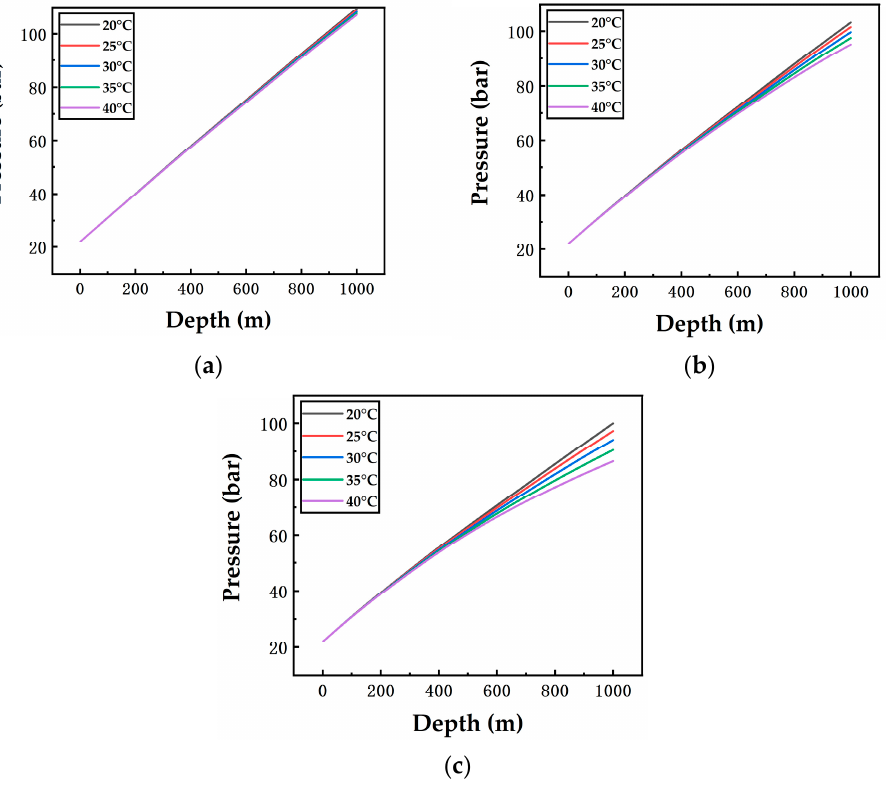
Figure 5. Variation of the on-way pressure with the depth in the vertical pipeline at different ambient temperatures and airflow velocities (( a ): 1 m/s; ( b ): 7.5 m/s; ( c ): 15 m/s).